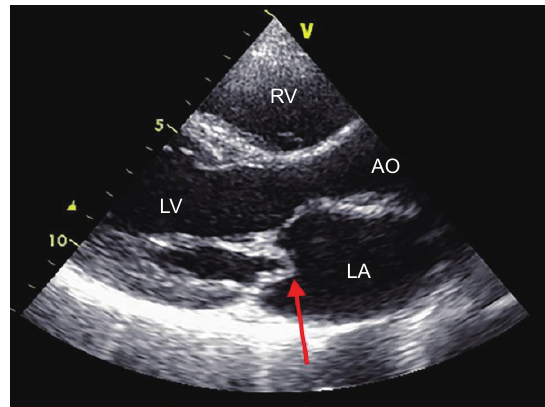
Figure 2 Apical four chamber view with continuous wave Doppler showing increased inflow velocity (mean gradient = 6.9 mmHg, PHT = 123 ms) through the mitral valve into the left ventricle measured.